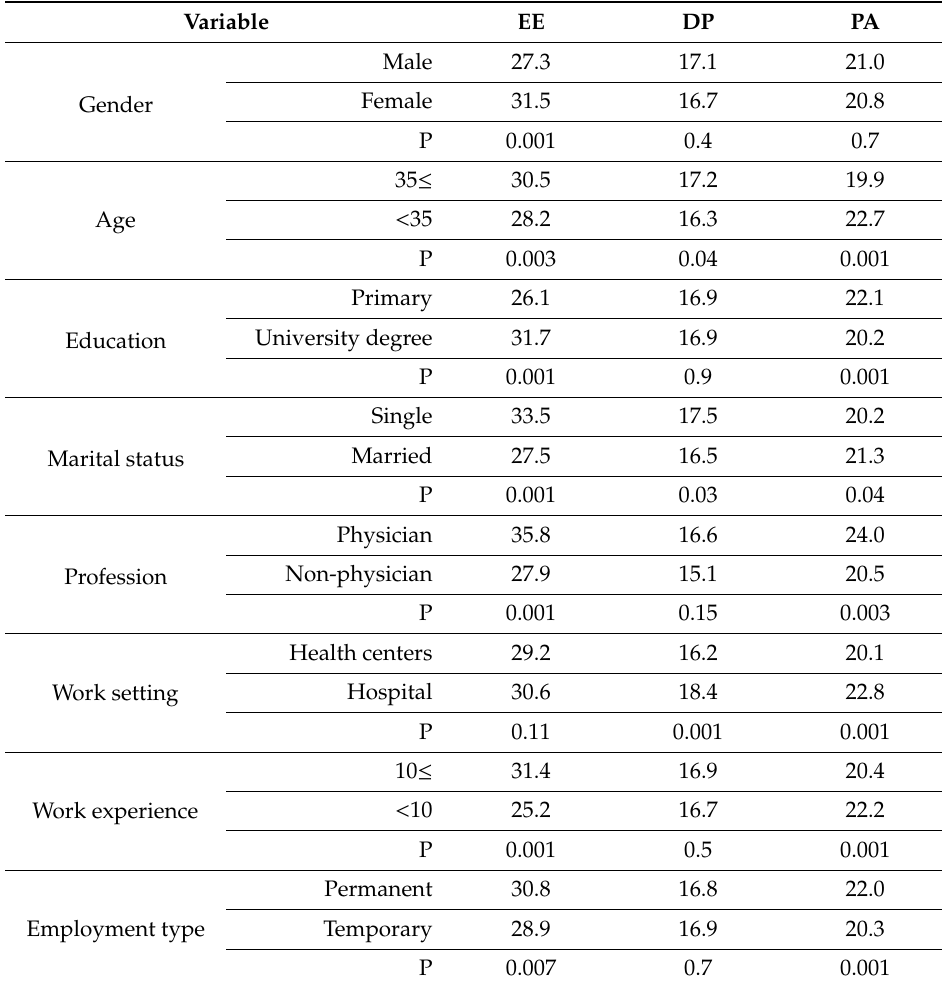
Table 4. Comparison of the mean burnout scores in terms of demographic